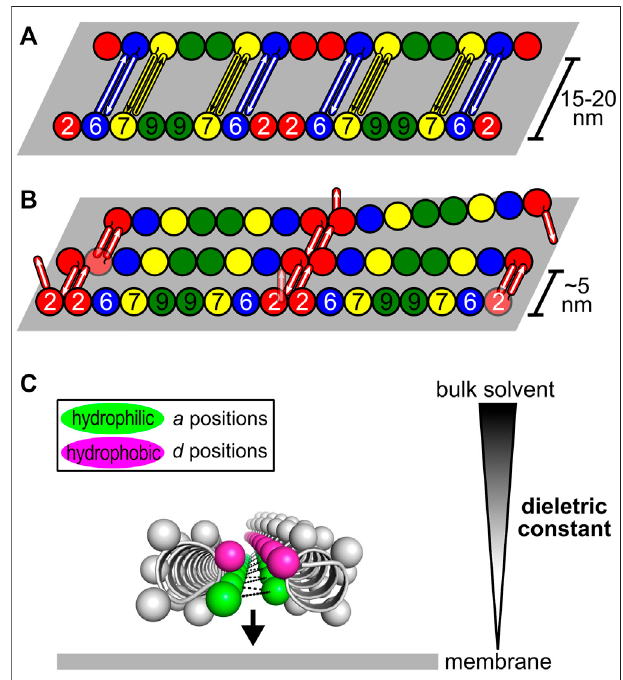
FIGURE11| Modelforhowantiparallelcoiledcoilscouldmediateseptin fi lament interconnections (Leonardo et al., 2021). The G- and the C-domains are represented as spheres and rods, respectively. (A) Loosely-paired fi laments (or a “ railroad-track ” ) separated by 15 – 20 nm are likely to be connected by antiparallel homodimers formed by the coiled coils of SEPT6 and SEPT7. (B) Tightly-paired sheets of fi laments interconnected by antiparallel homodimers of SEPT2 coiled coils. (C) Solvent-protection of the hydrophilic side of the interface ( a positions, green) in the antiparallel coiled coils. By facing the membrane, where the dielectric constant is lower than in bulk solvent, the formation of polar interactions is favored (black